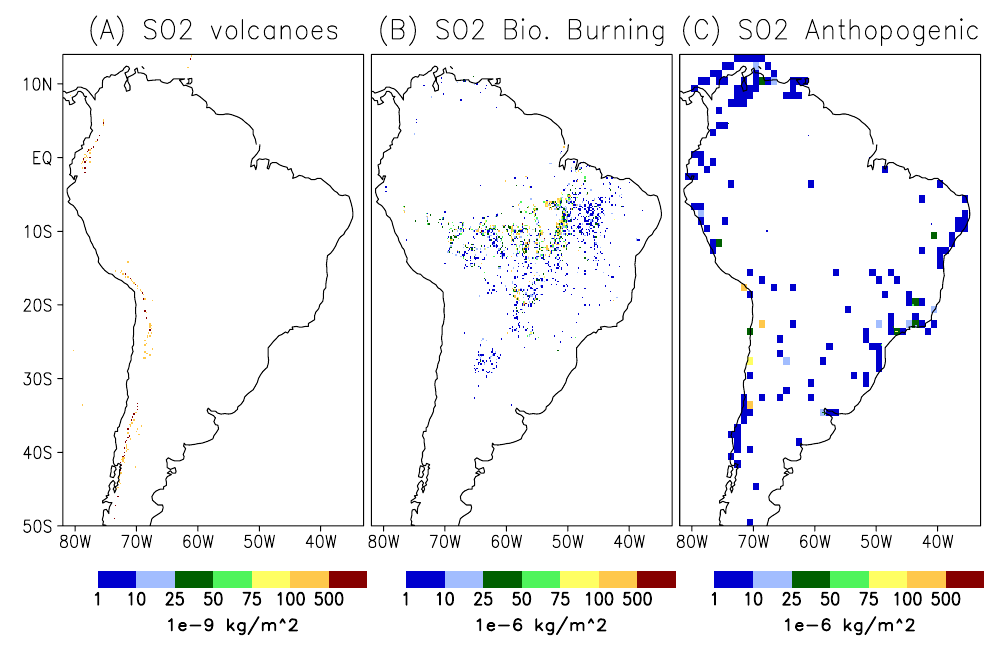
Fig. 5. Different sources of SO 2 estimated for 27 August 2002 on a rectangular projection grid with spatial resolution of 0.2 ◦ × 0.2 ◦ . Panel (A) represents volcanic emission following Diehl, 2009 inventory, (B) biomass burning from 3BEM and (C) anthropogenic SO 2 using EDGAR.